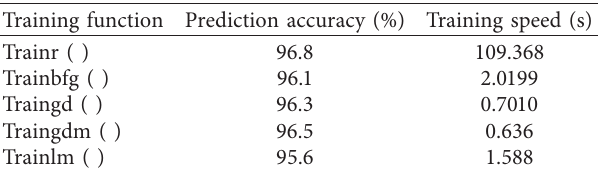
Figure 3: Relationship between model prediction error and the number of nodes in hidden layer. Table 1: Prediction accuracy and training speed of each candidate training